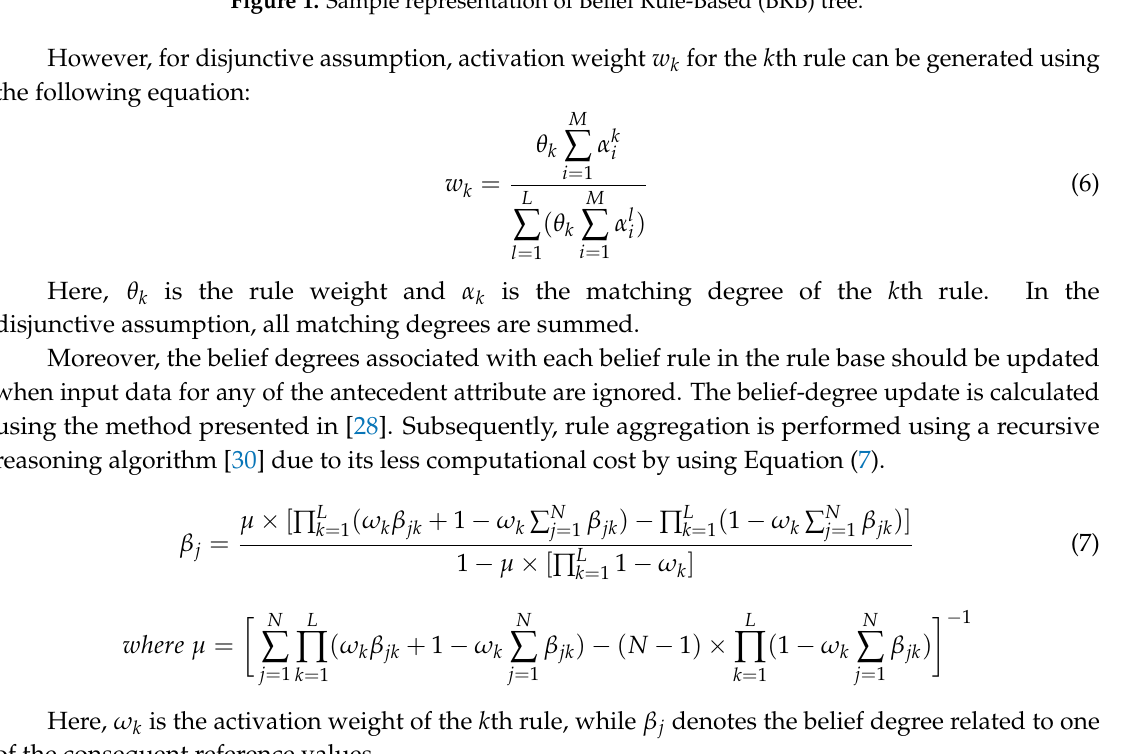
Figure 1. Sample representation of Belief Rule-Based (BRB)